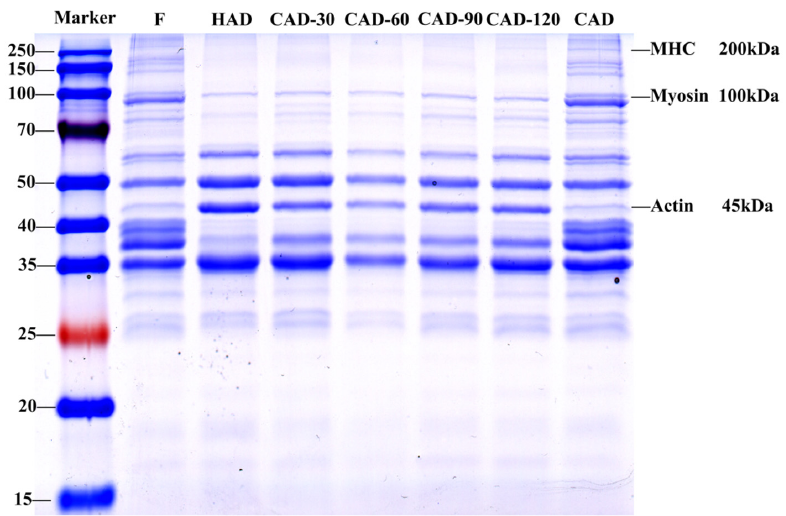
Figure 5. SDS-PAGE of myofibrillar proteins from semi-dried pufferfish fillets dried using different methods. F, fresh, undried fillets; HAD, hot air drying; CAD, cold air drying; CAD-30, cold air drying for 30 min; CAD-60, cold air drying for 60 min; CAD-90, cold air drying for 90 min; CAD-120, cold air drying for 120 min.